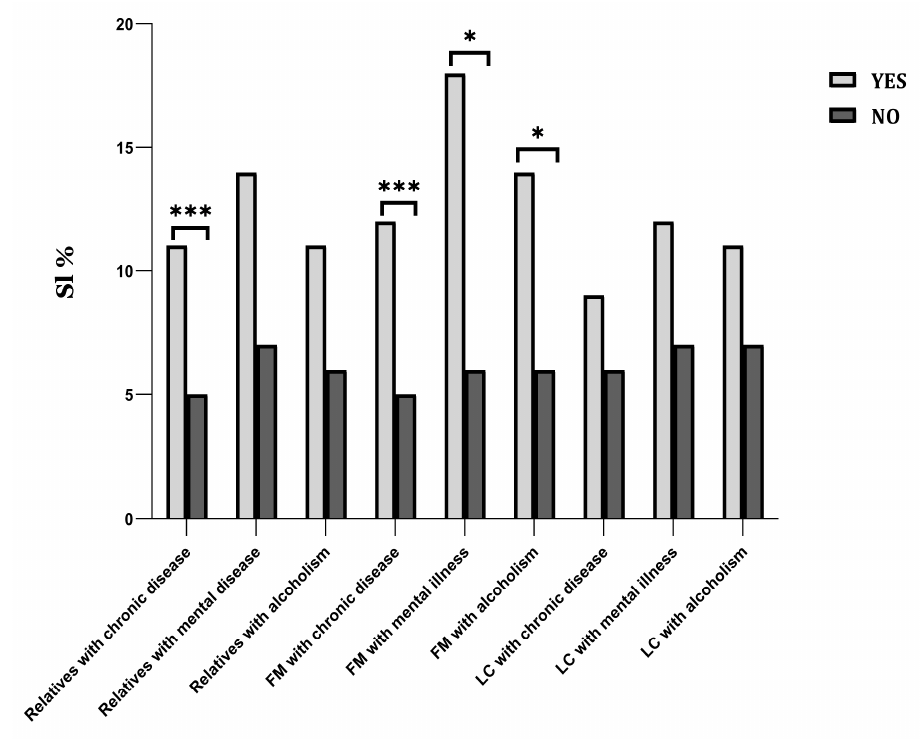
Figure 1. Visual comparisons for suicidal ideation under different relatives’ characteristics. Note: FM = Family member, LC = lineal consanguinity, and SI = suicidal ideation; * p < 0.05, *** p < 0.001.